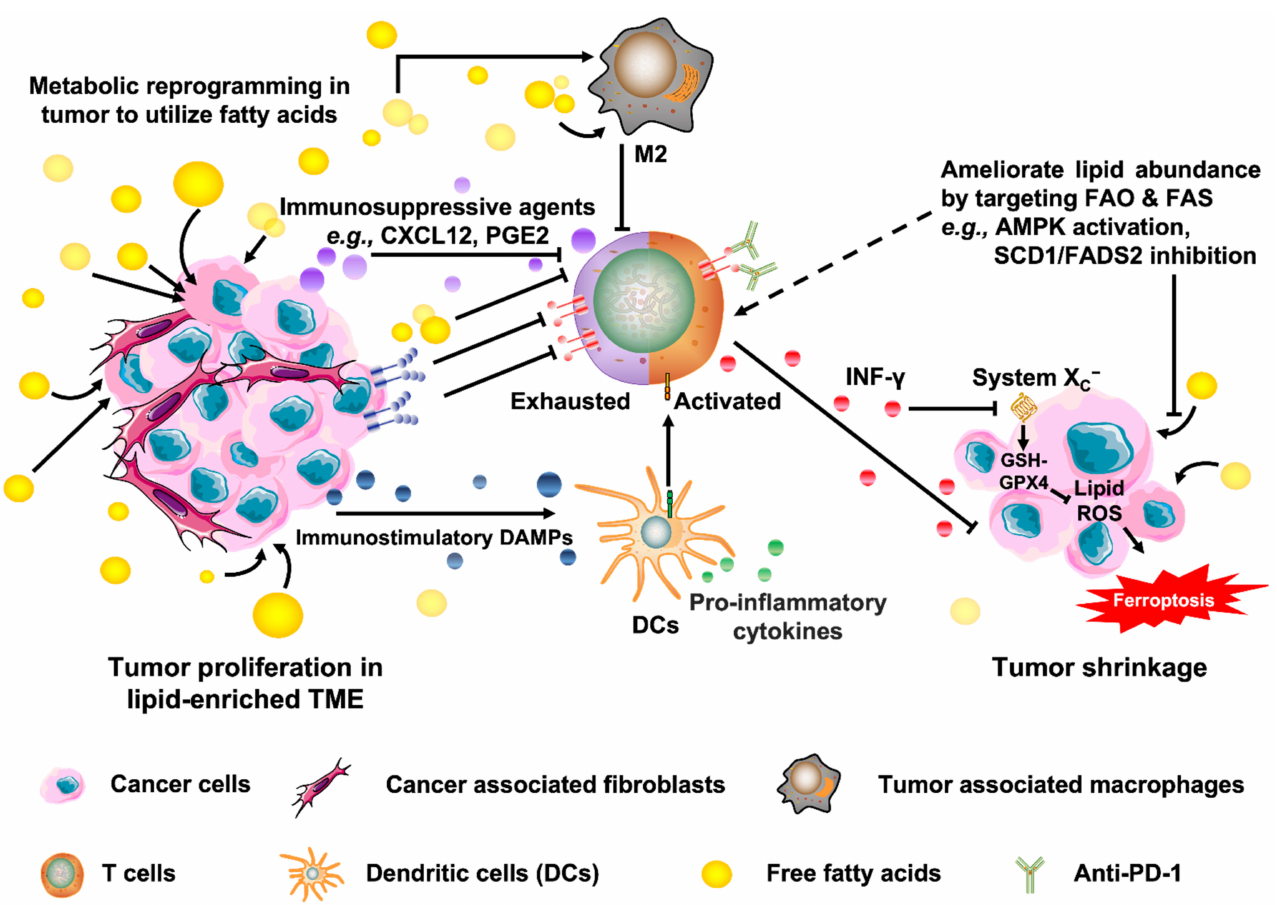
Figure 4. A schematic diagram to illustrate the metabolic alternations and immunogenic features of ferroptotic cancer cells. On the one hand, targeting fatty acid metabolism for cancer immunotherapy as the proposed molecular mechanism to down-regulate the accumulation of fatty acids in cancer cells and TME and subsequently inhibit tumor growth. On the other hand, ferroptosis has been proposed to play a significant role in mediating various functions during immune responses. Ferroptotic cancer cells release DAMPs such as ATP and HMGB1 that act as immune modulators stimulating the matu- ration of antigen-loaded DCs. The activated DCs subsequently release pro-inflammatory cytokines and present TAA to activate CD8 + T cells, which release IFN- γ and downregulate system X C − and eventually induce